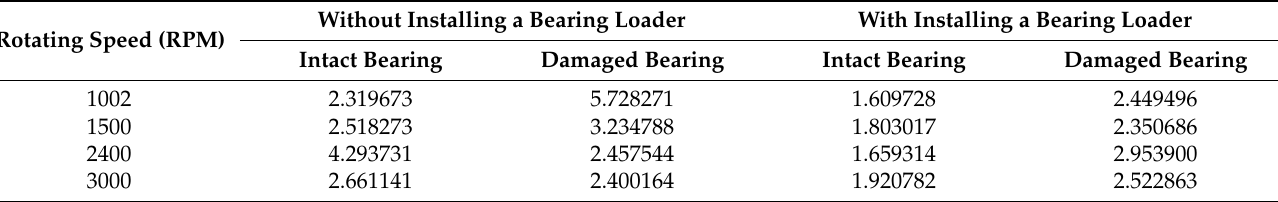
Table 5. Averaged kurtosis values for an outer race